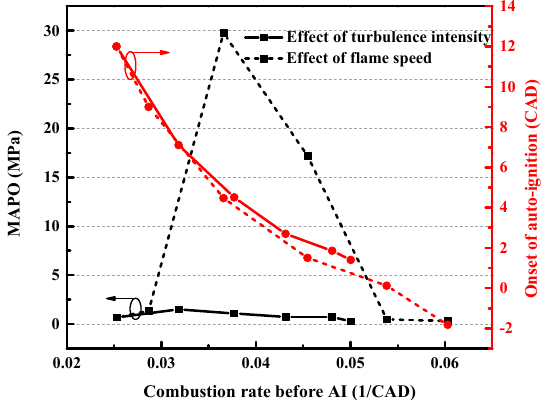
Figure 17. Relationship between MAPO and the combustion rate before auto-ignition as increasing the flame speed and increasing the turbulence intensity.